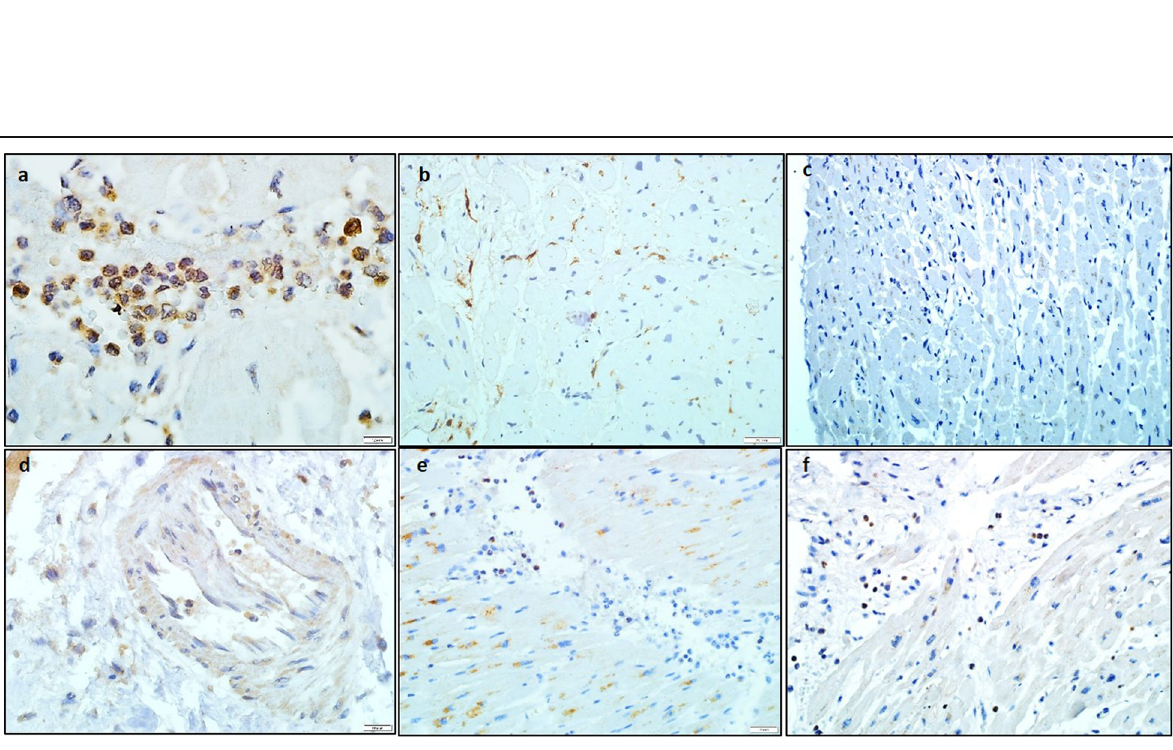
Fig. 2 Immunohistochemical characteristics of myocarditis in COVID-19. A - CD 3 lymphocytes in myocardial stroma (more than 7 CD3+ lymphocytes per 1 mm 2 ), B - CD68 macrophages in myocardial stroma, C - absence of CD20 expression, D - pronounced TLR 4 type expression in cardiomyocyte cytoplasm, endothelium and infiltration cells; E - weak TLR 9 type expression in cardiomyocyte cytoplasm, single macrophages; F - absence of NK cells (perforin expression). Immunoperoxidase method with diaminobenzidine, magnification × 600 (a,d), × 200 (b,c,e), × 100